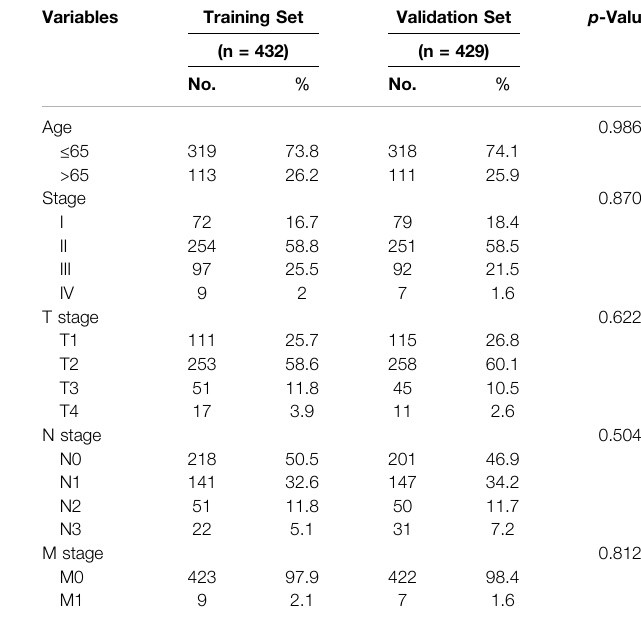
TABLE 1| The associationbetweenriskscoreand patients ’ clinical features inthe training